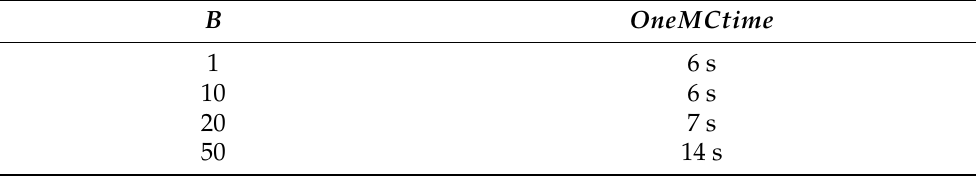
Table 1. Computational load